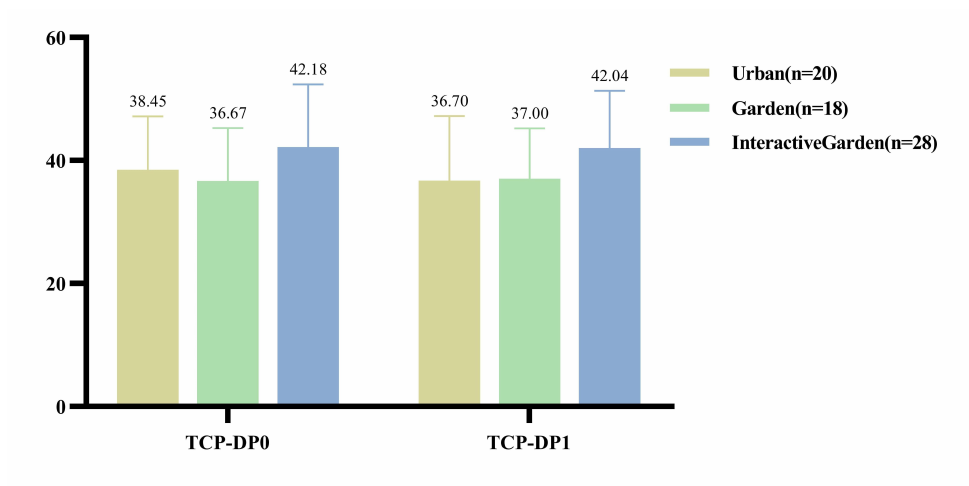
Figure 5. Descriptive statistical results of the total score of